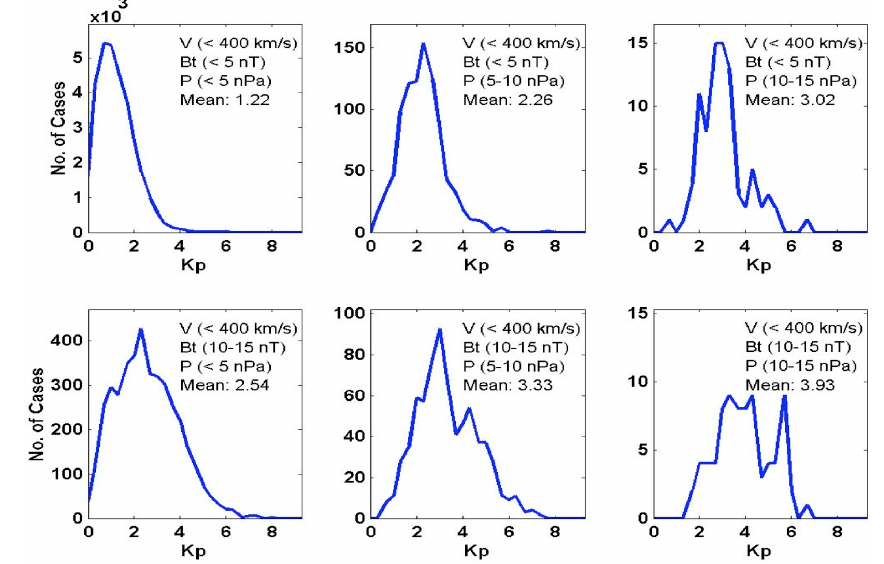
Fig. 2. Examples of reduced histograms of K p when V sw , P sw and B tot are successively localized. In these examples, we have kept V sw < 400kms − 1 while P sw increases from left ( < 5nPa) to right (10–15nPa) and the magnitude of IMF B tot increases from top ( < 5nT) to bottom (10–15nT). We see that the peaks of the K p distributions shift to higher K p values as both P sw and B tot increase. In Figs. 1 and 2, concurrent data are